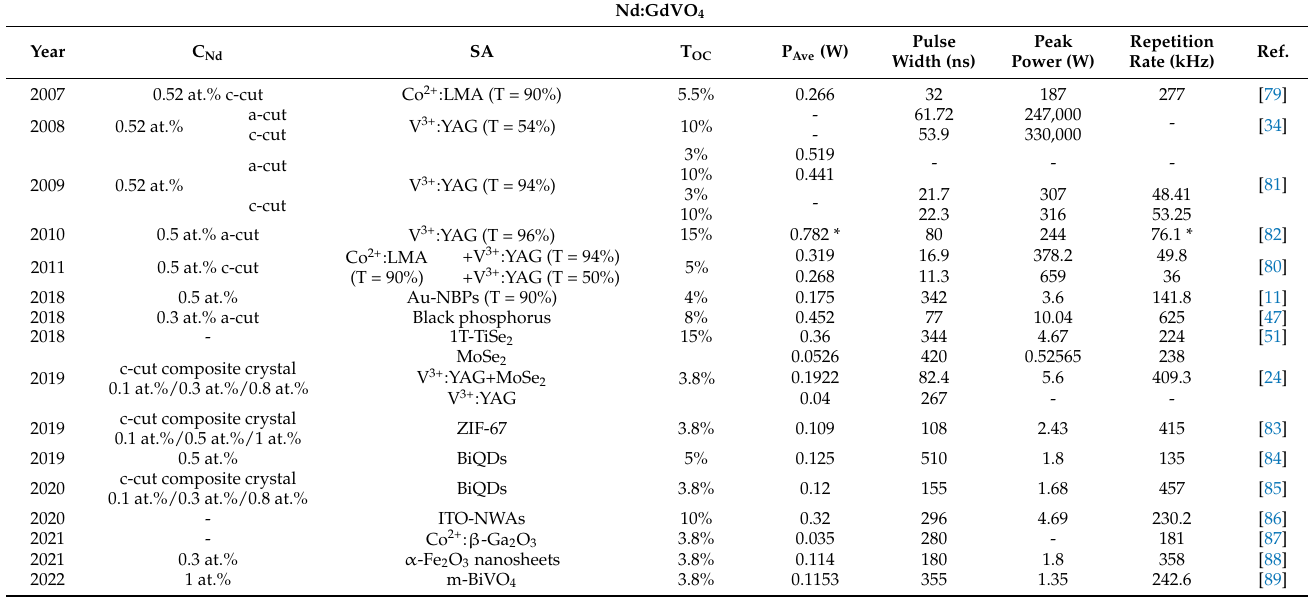
Table 2. Research progress on 1.3 µ m passively Q-switched Nd:GdVO 4